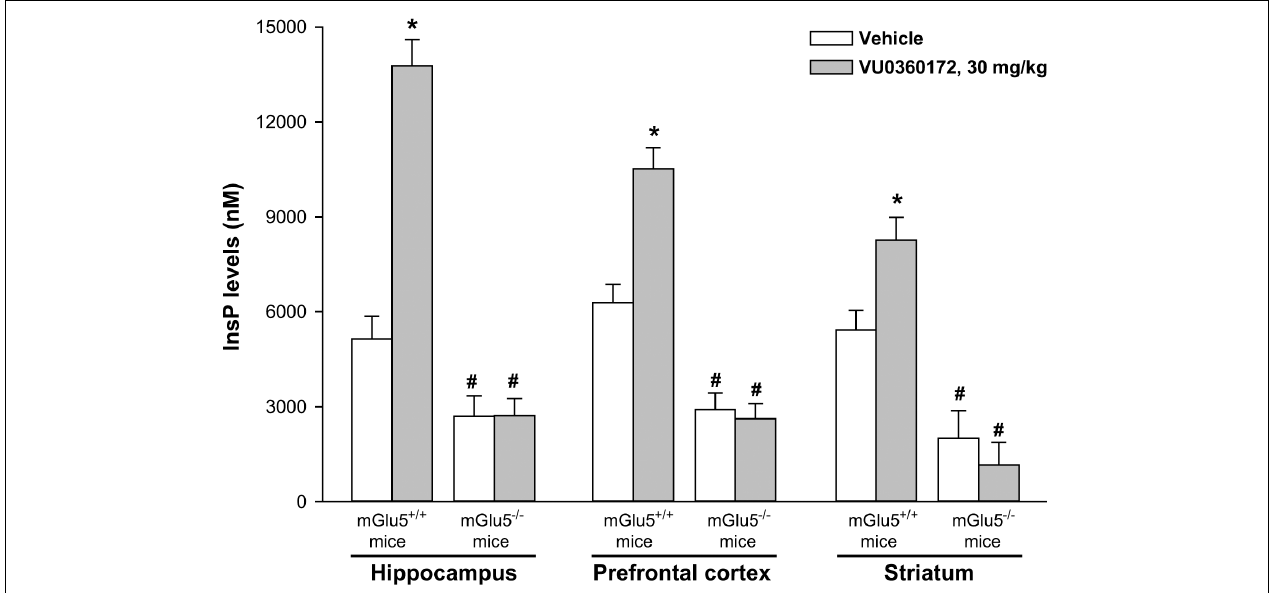
FIGURE 3 | Systemic treatment with VU0360172 failed to stimulate PI hydrolysis in the hippocampus, prefrontal cortex and striatum of mice lacking mGlu5 receptors. mGlu5 + / + and mGlu5 - / - mice were treated with 10 mmol/kg of lithium chloride followed by either vehicle or VU0360172 (30 mg/kg). Values are means + SEM of 3–6 mice for the prefrontal cortex, 3–7 mice for the hippocampus and 2–4 mice for the striatum p < 0.05 vs. the respective groups of vehicle-treated mice ( ∗ ) or vs. the respective groups of mGlu5 + / + mice (#) [Two-way ANOVA + Fisher’s LSD; F ( 1 , 15 ) = 94.99 for hippocampus; F ( 1 , 14 ) = 99.51 for prefrontal cortex; F ( 1 , 8 ) = 51.15 for